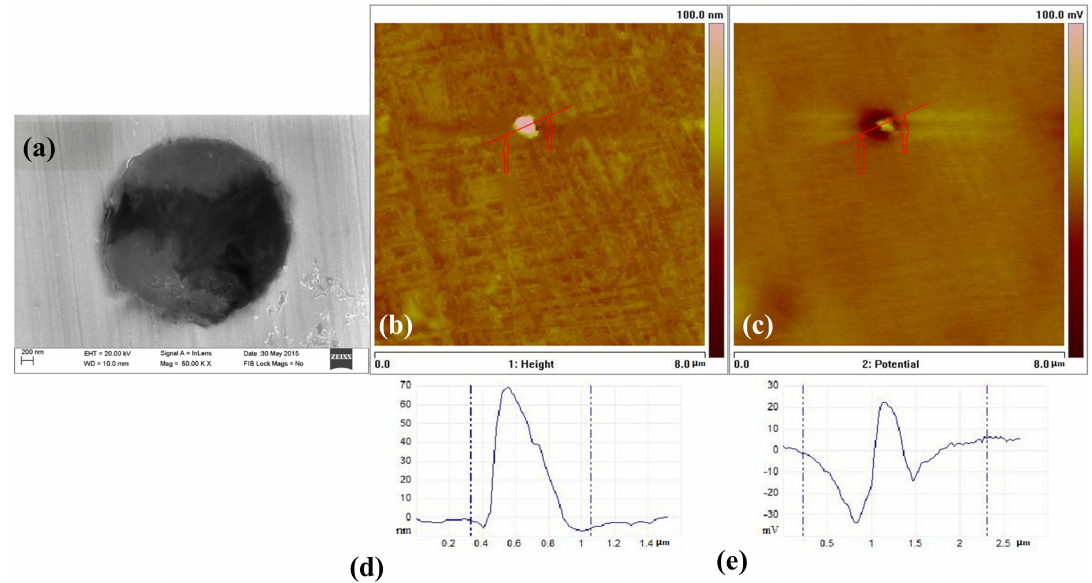
Figure 8. SEM and SKPFM images around the type A inclusion: ( a ) SEM image; ( b ) AFM topography image; ( c ) Surface potential distribution of the same area; ( d ) Topography section analysis and ( e ) Section analysis of the surface